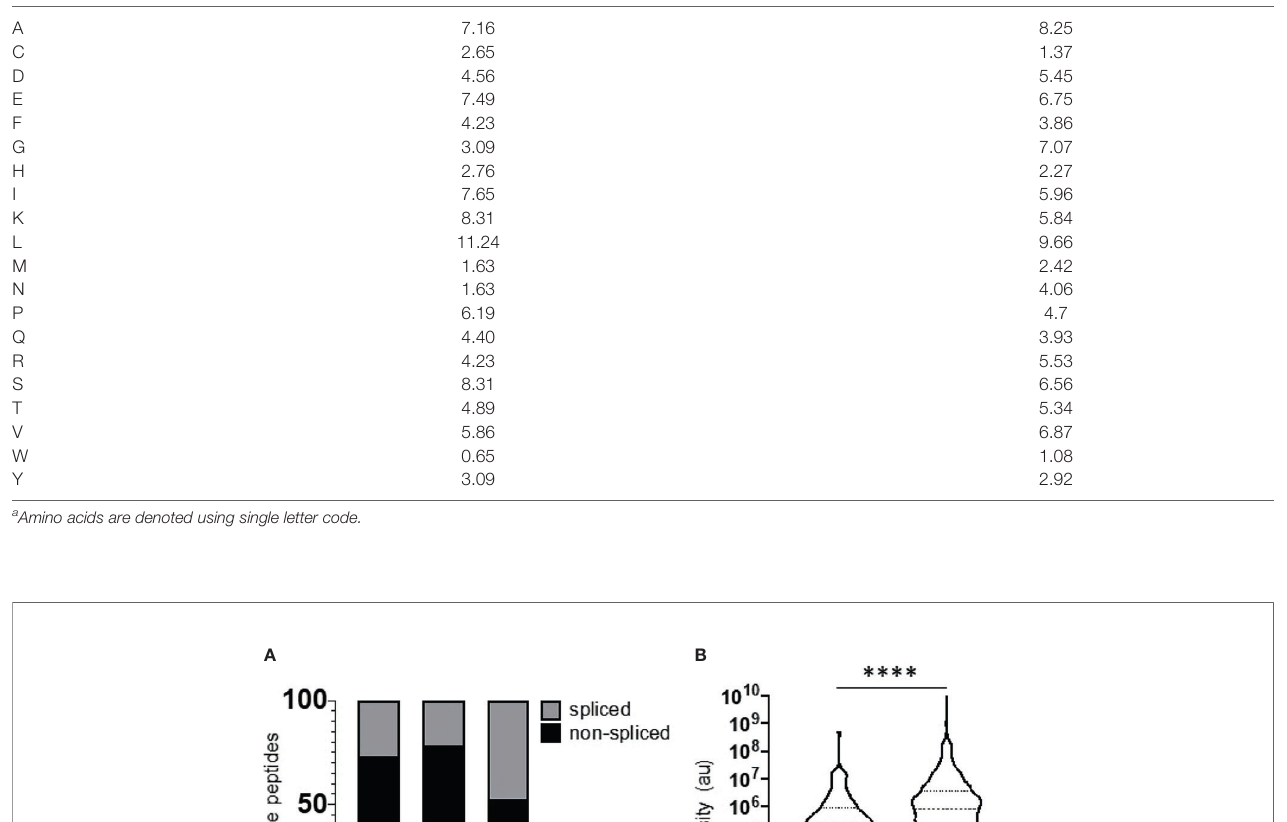
TABLE 2 | Amino acid frequencies within synthetic polypeptides and combined HIV-1 and UniProt human proteomes. Amino acid